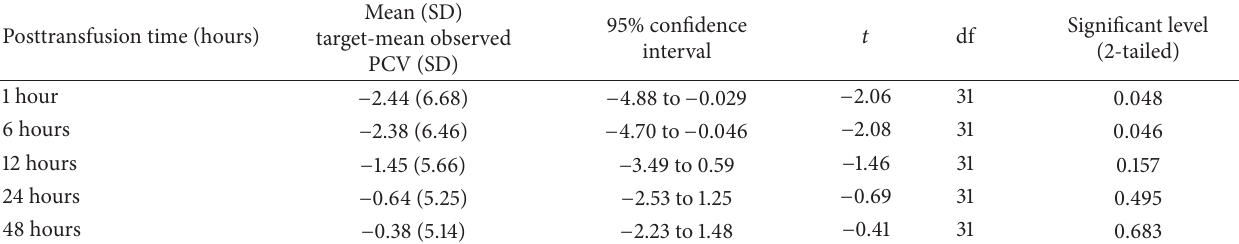
Table 3: Mean target PCV versus mean observed posttransfusion